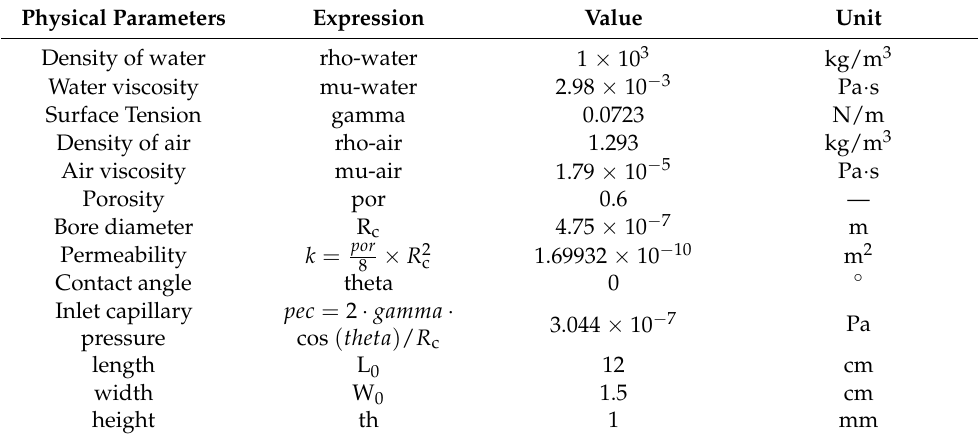
Figure 3. Effect diagram of the nonwoven fabric impregnation process (the above picture is from the first group, porosity 0.6-pore 4.75 × 10 − 7 m). Table 1. Parameter